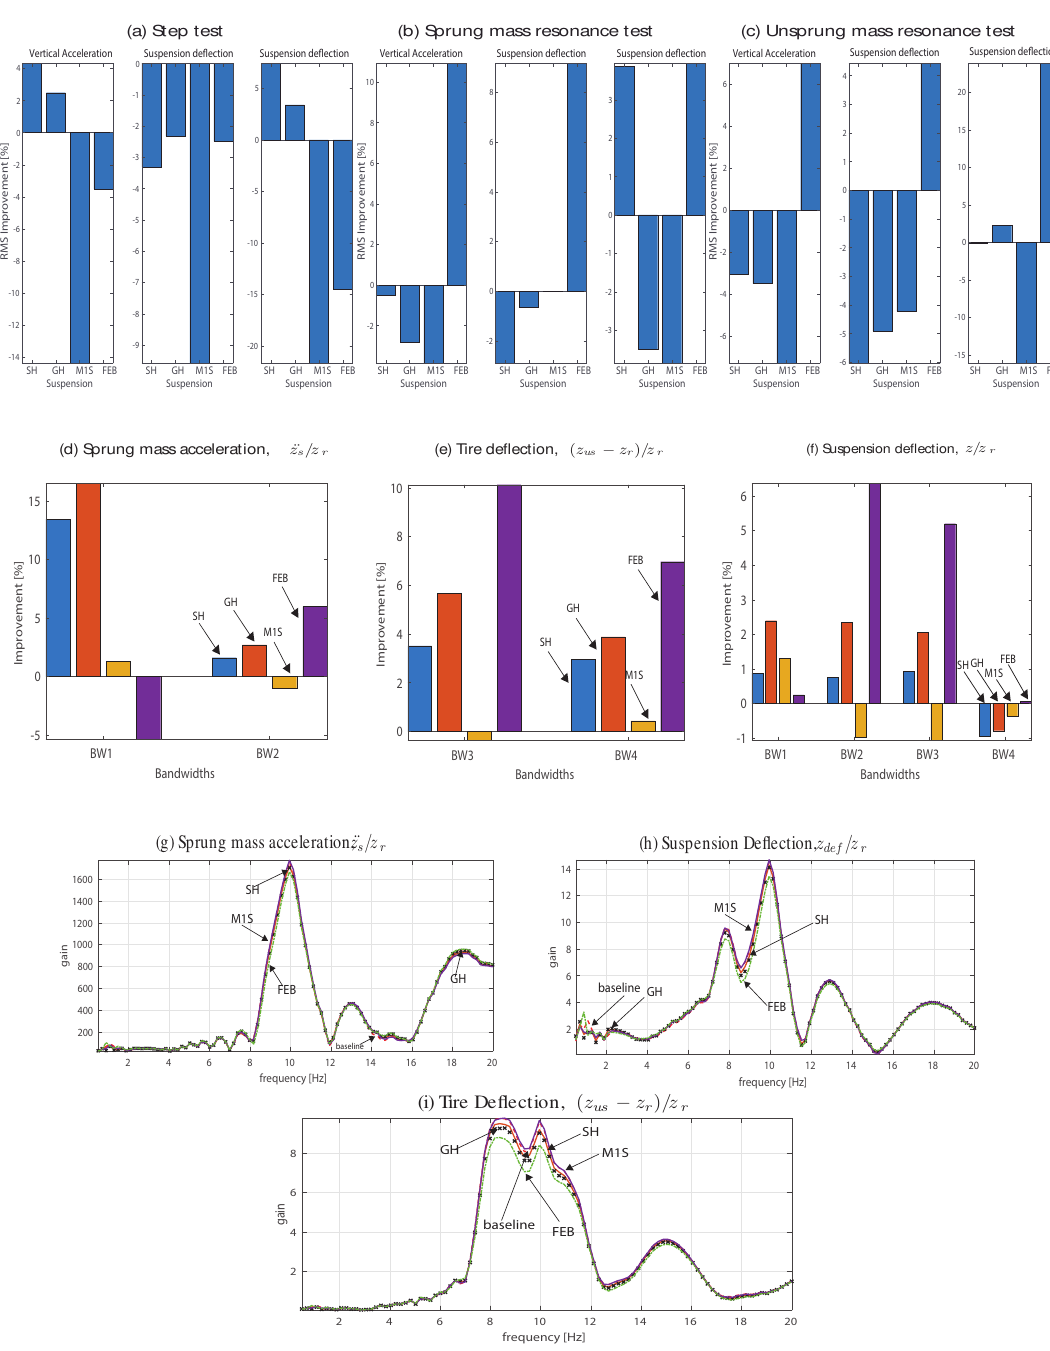
Figure 18. Results from closed simulations for the comparison in a nonlinear modified QoV model considering a 1.25 A baseline suspension and the residual vertical